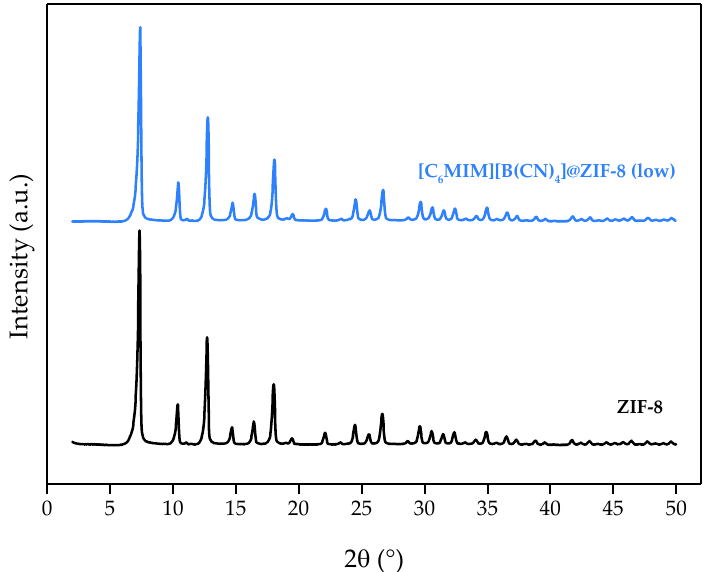
Figure 2. PXRD diffractograms of [C 6 MIM][B(CN) 4 ]@ZIF-8 (low) and pristine ZIF-8.